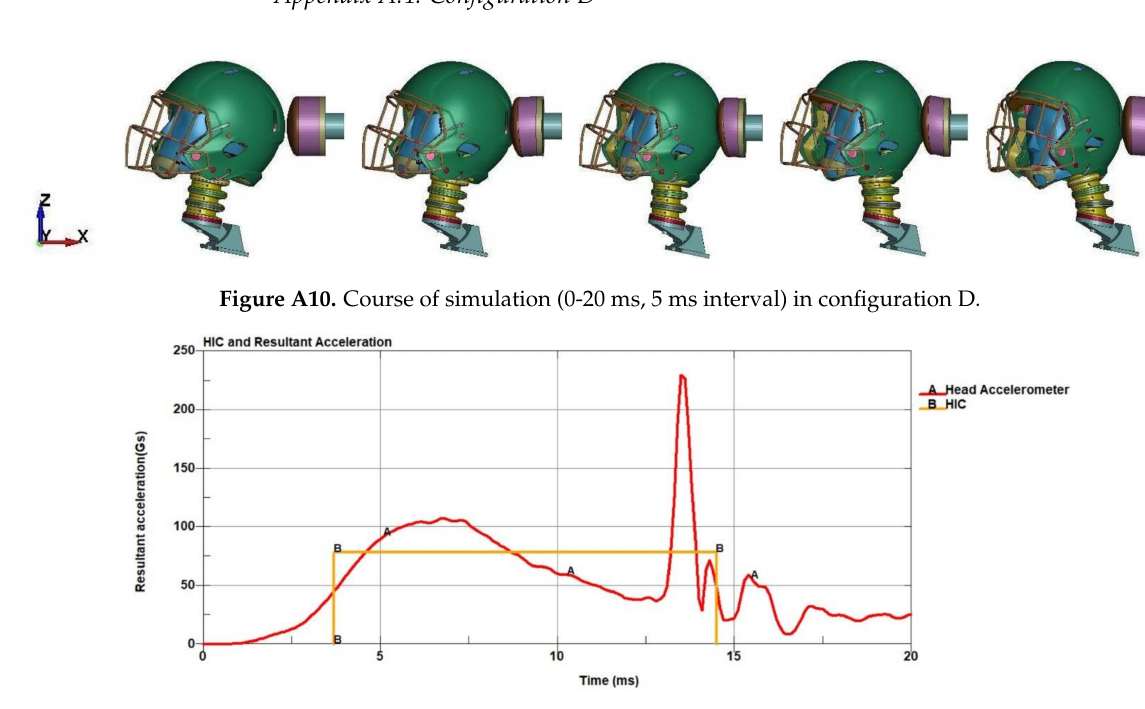
Figure A11. HIC and resultant acceleration (g) in time (ms) plot (HIC = 594). Brain Sci. 2021 , 11 , x FOR PEER REVIEW